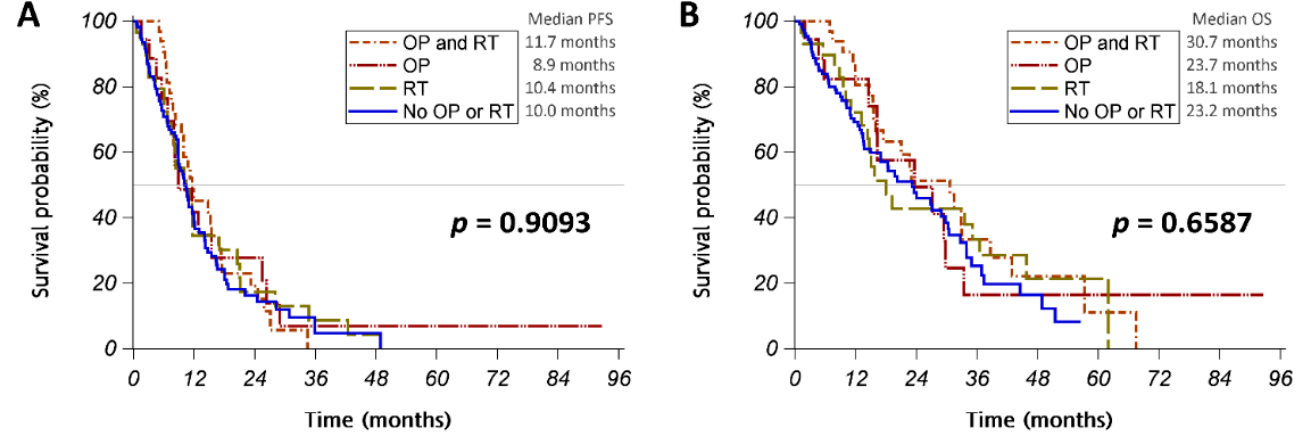
Figure A1. ( A ) Progression-free survival (PFS) and ( B ) overall survival (OS) of patients classified according to those undergoing or not undergoing surgery (OP) or radiotherapy (RT) for a brain